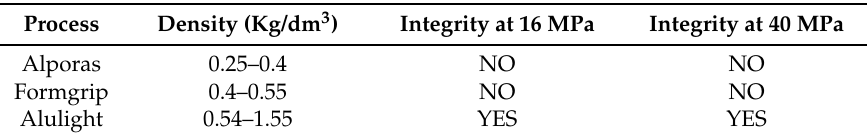
Table 4. Integrity of aluminium foams after plastic injection.